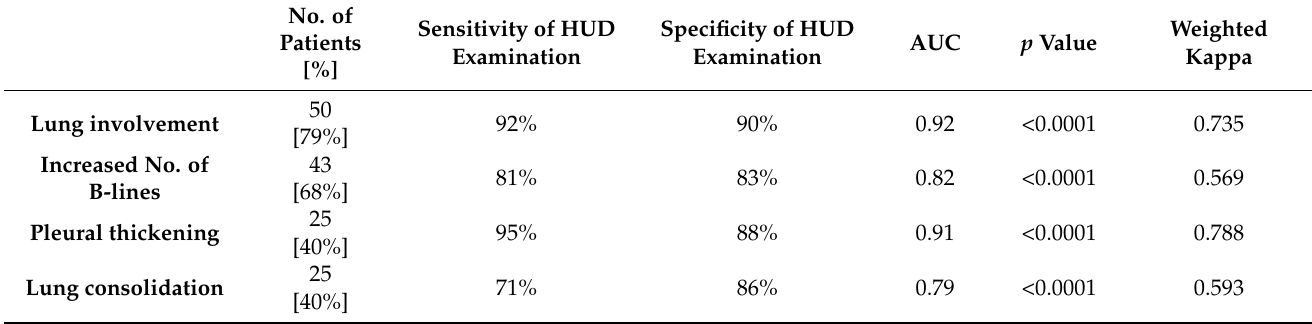
Table 2. Diagnostic value parameters of lung HUD examination. Chest CT scan was treated